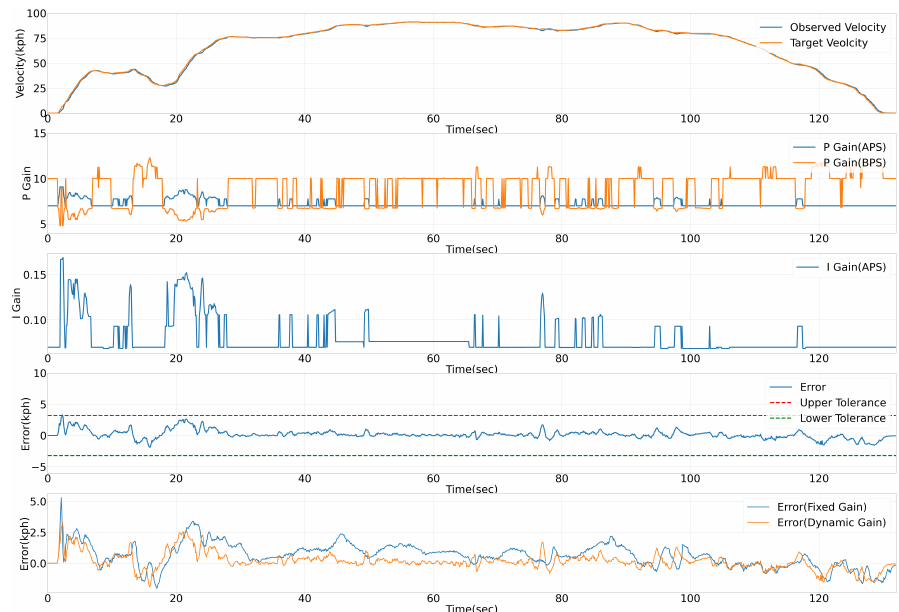
Figure 18. Test Results of Dynamic Gain Method in Eco